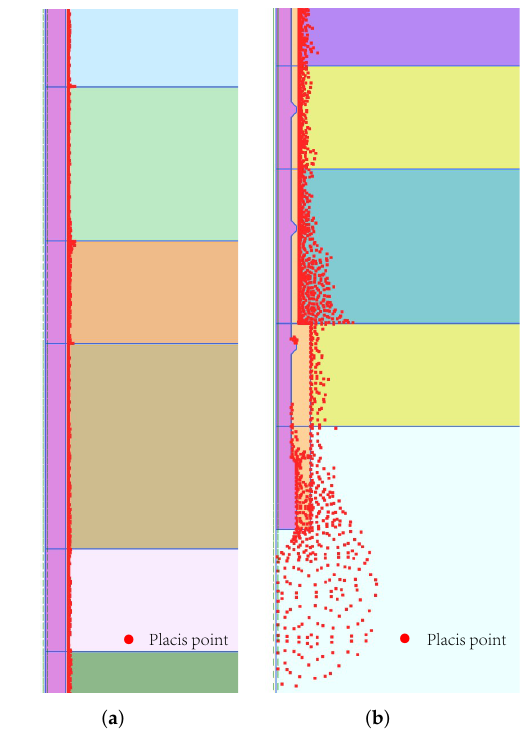
输出 Version 20.1.0.98